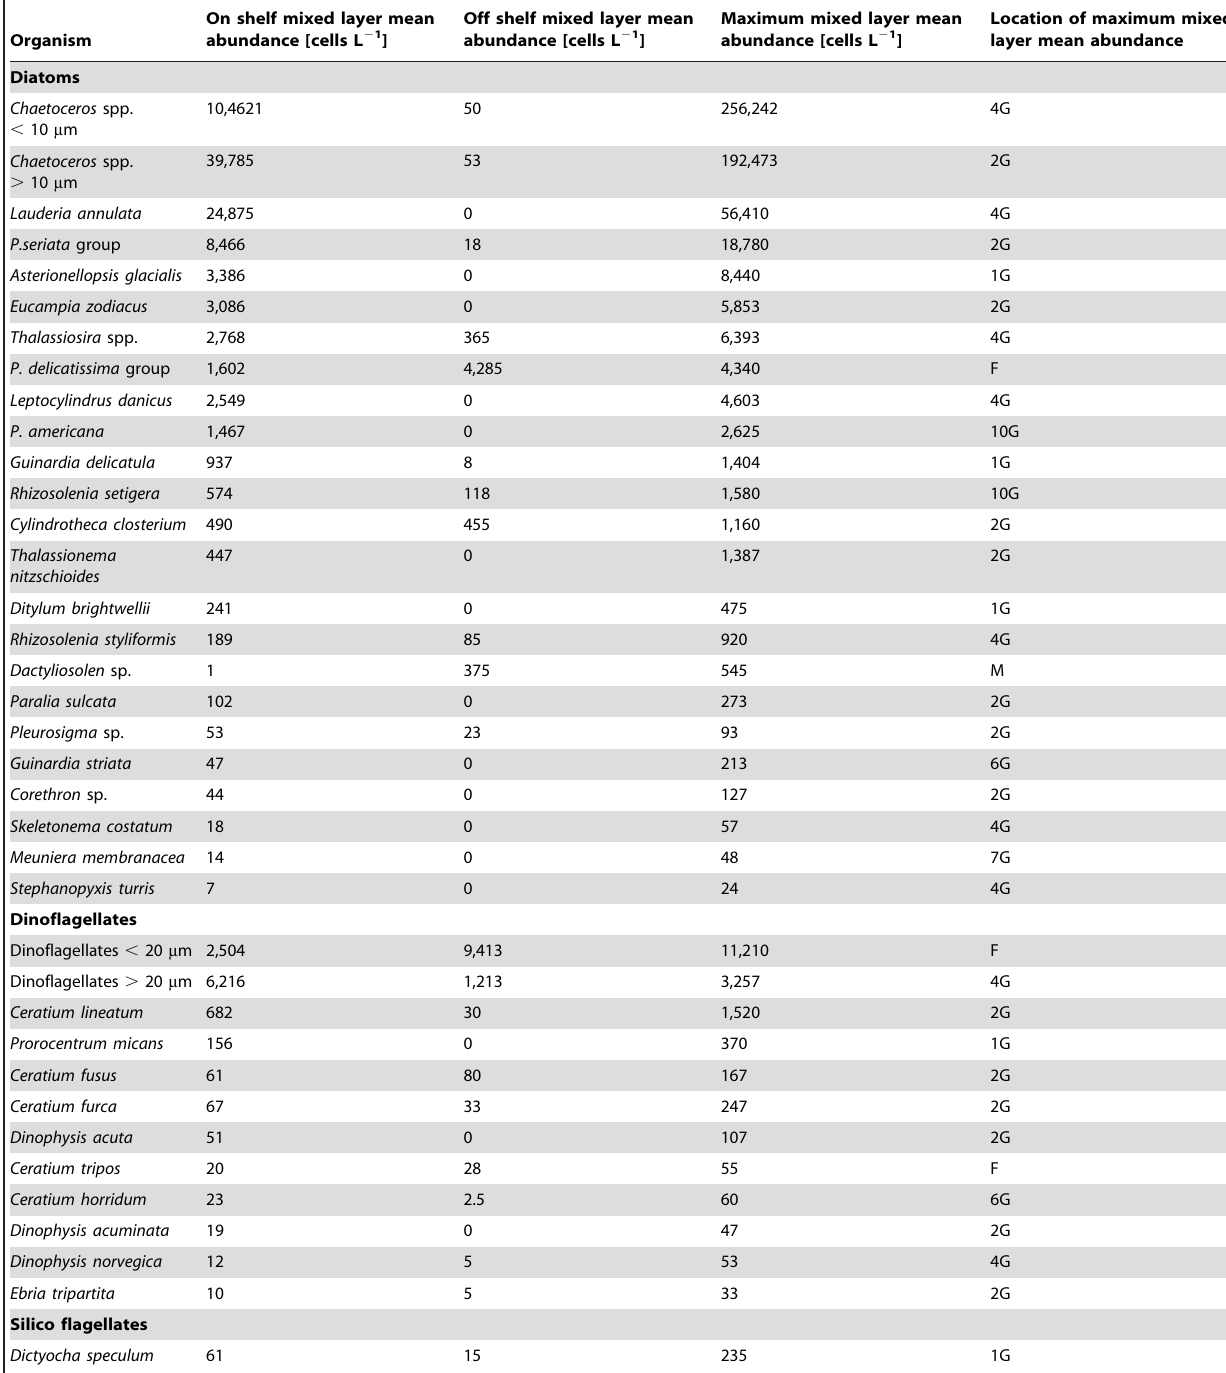
Table 1. Enumerated phytoplankton species.